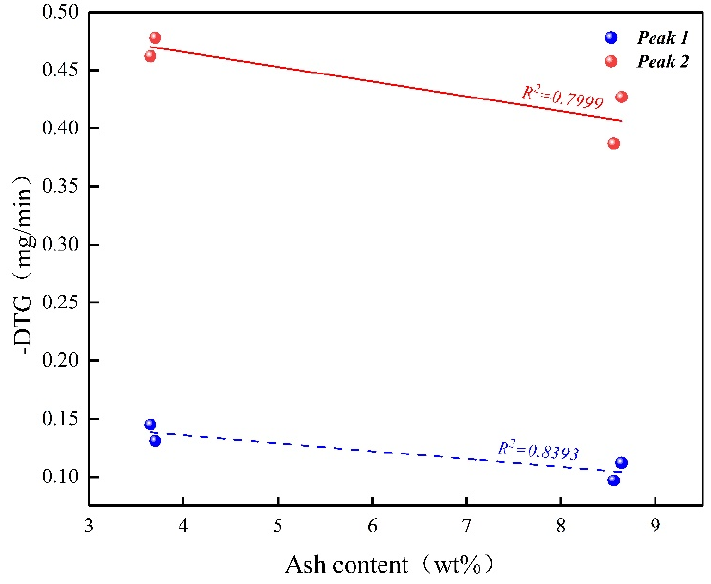
Figure 10. Relationship between ash content and maximum weight loss rate.